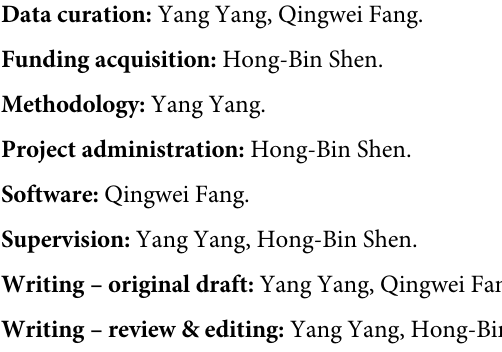
S1 Fig. The hub genes extracted from top 1000 predicted links and their megerd network. The six hub genes, i.e. CG12054 , Hsf , kay , lola , Eip75B and GATAe , are highlighted with yellow background. (TIF) S2 Fig. The hub genes extracted from top 3000 predicted links. (A) shows the targets of grh and l(1)sc , (B) and (C) show the targets of gt and ase , respectively.